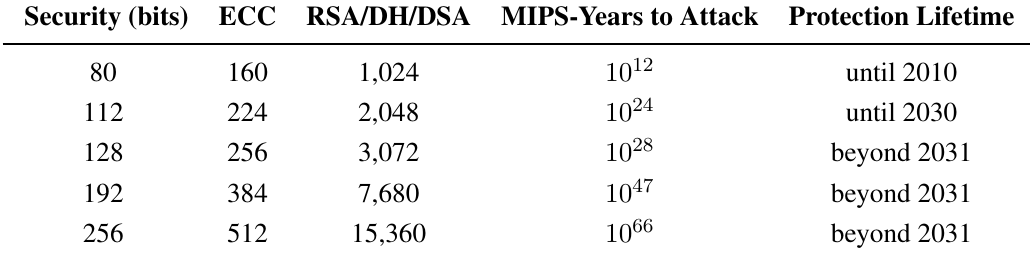
Table 1. ECC key sizes compared with other PKC